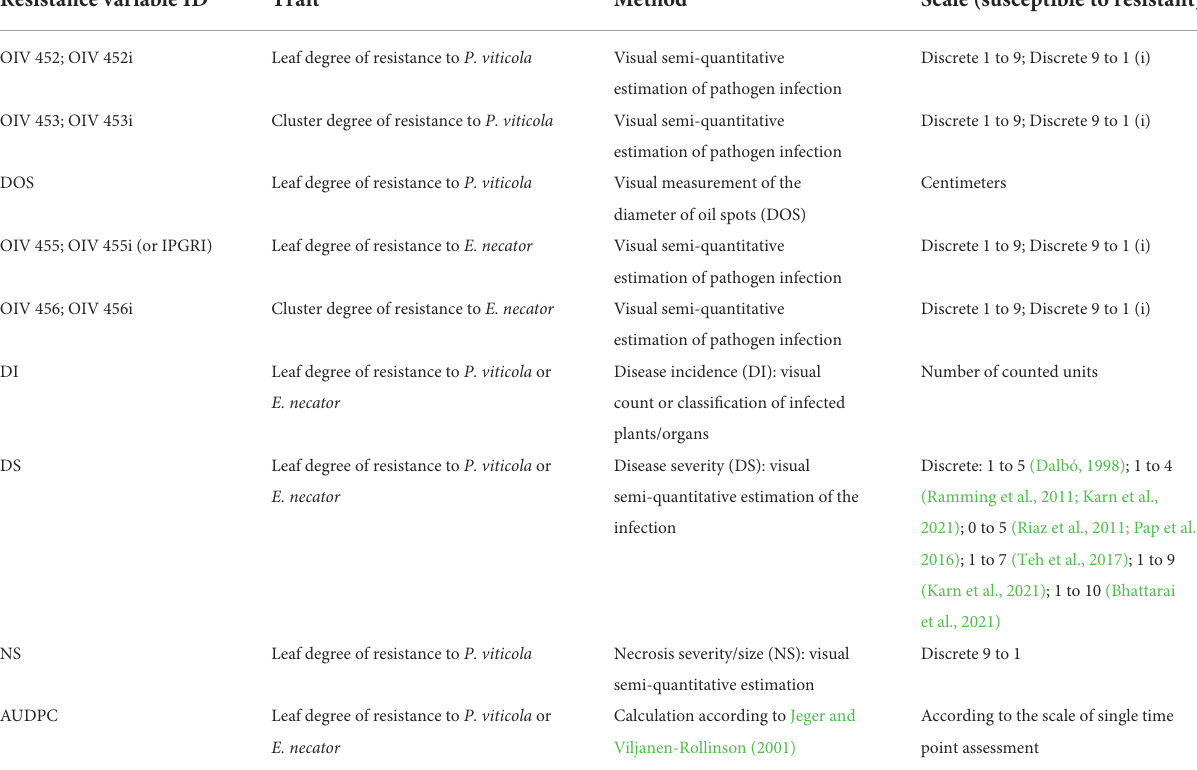
TABLE 3 Resistance variables assessed in the vineyard and greenhouse. An abbreviation and a description of the method and scale utilized for the scoring is proposed for each resistance variable assessed in mapping studies. Resistance variable